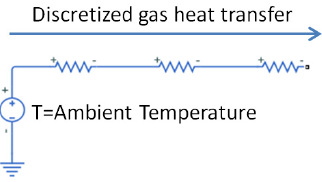
Figure 10. Prototype of gas heat transfer contribution.